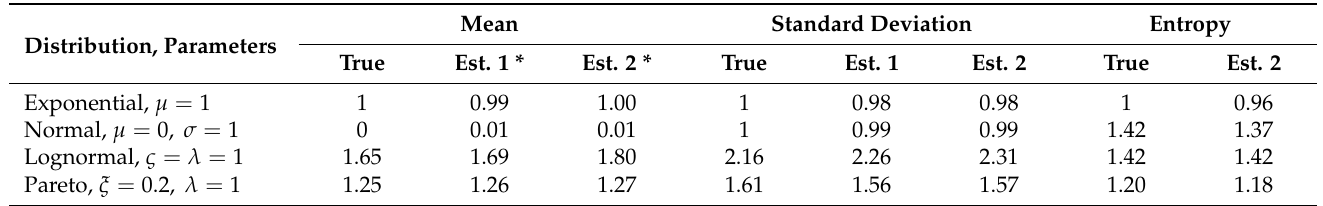
Table 4. Estimated means, standard deviations and entropies: averages from the 100 Monte Carlo simulations performed in the study with sample size